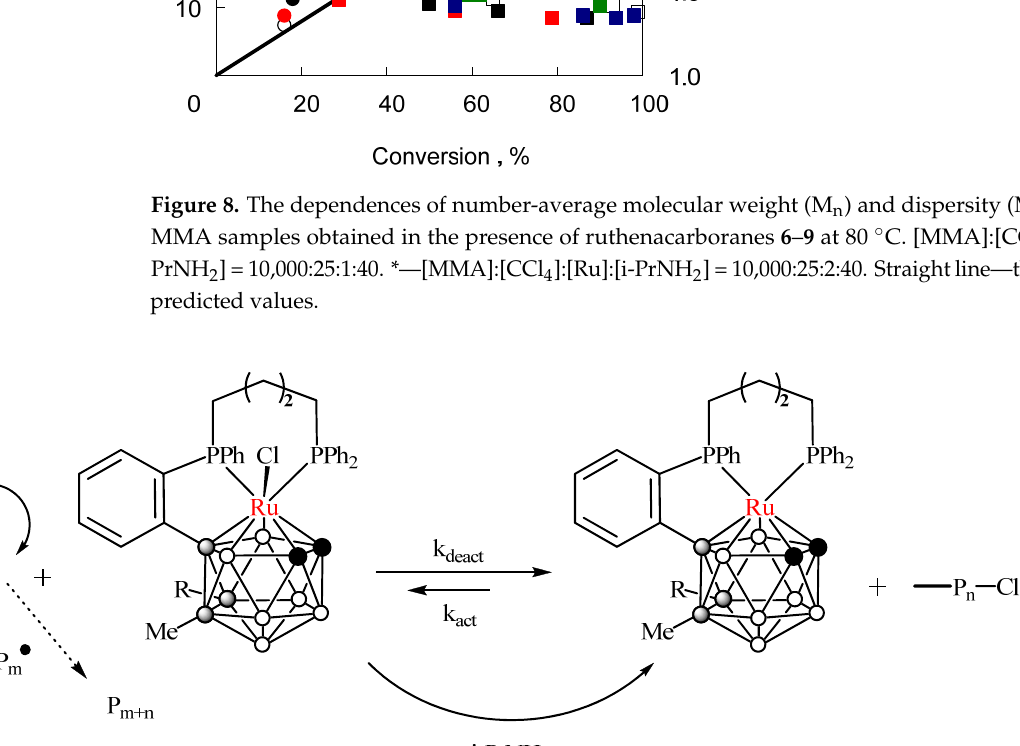
Figure 7. The dependences of ln[M] 0 /[M] versus time for polymerization of MMA in the presence of ruthenacarboranes 6 – 9 at 80 °C. [ ММА ]: [CCl 4 ]: [Ru]: [i-PrNH 2 ] = 10000: 25: 1: 40. *—[ ММА ]: [CCl 4 ]: [Ru]: [i-PrNH 2 ] = 10000: 25: 2: